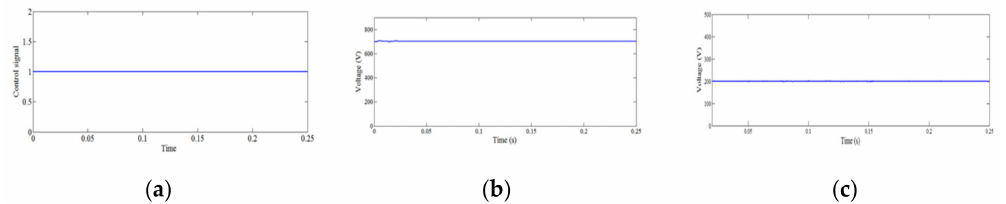
Figure 7. Simulation results of ( a ) sliding mode controller output; ( b ) buck-boost converter output voltage (Boost Mode); ( c ) Buck converter output voltage.